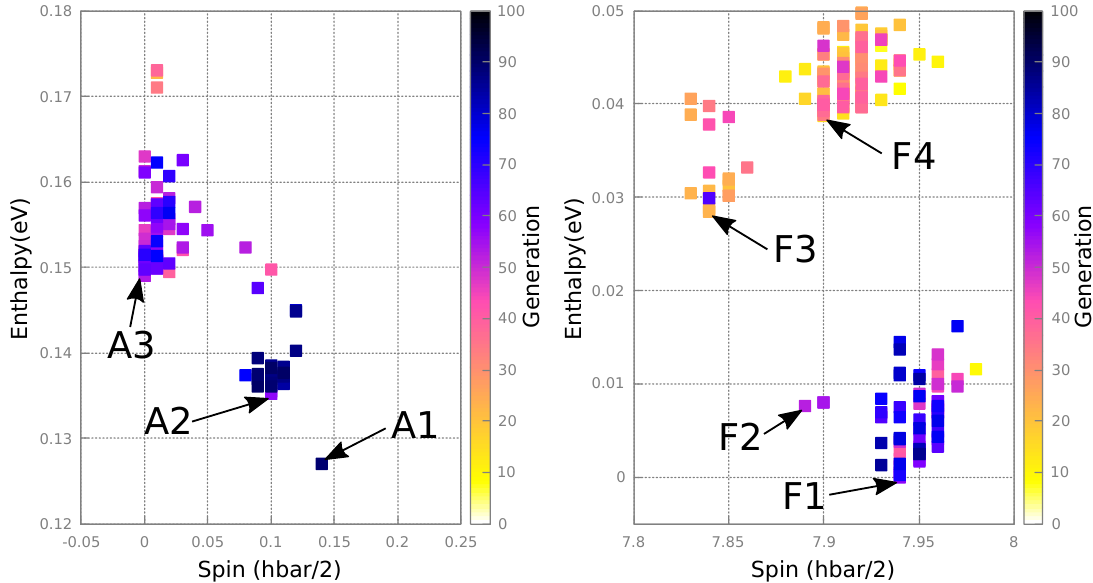
Figure 14. Clustering of CFAS/Ge structures around the AFM ( left ) and FM ( right ) configurations of the interface phase. In each case, a number of distinct structures have been identified (A1–3,